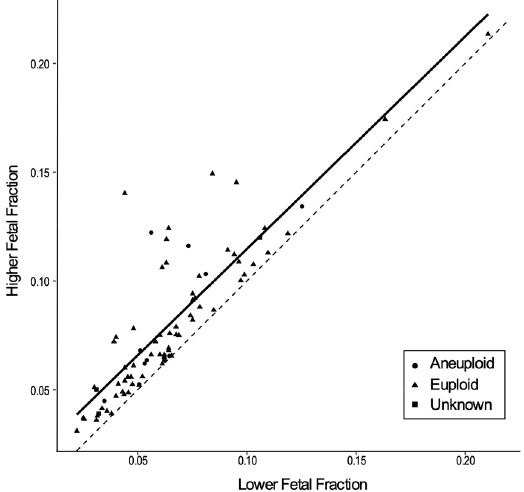
Figure 3. Scatterplot of fetal fraction estimates of dizygotic twins. Legend: Scatterplot of higher and lower fetal fraction estimates of dizygous twin samples ( n = 79). Samples include cases that were aneuploid (circles) and euploid (triangles). Presence or absence of chromosome abnormality was unknown for three cases (squares). Aneuploid samples include cases affected with either T21, T18, or T13. The solid line represents the linear regression line; the dotted line represents the line of equal fetal fractions (reference 45-degree line). The Pearson Correlation Coefficient was 0.860 (95% CI, 0.736–0.937).